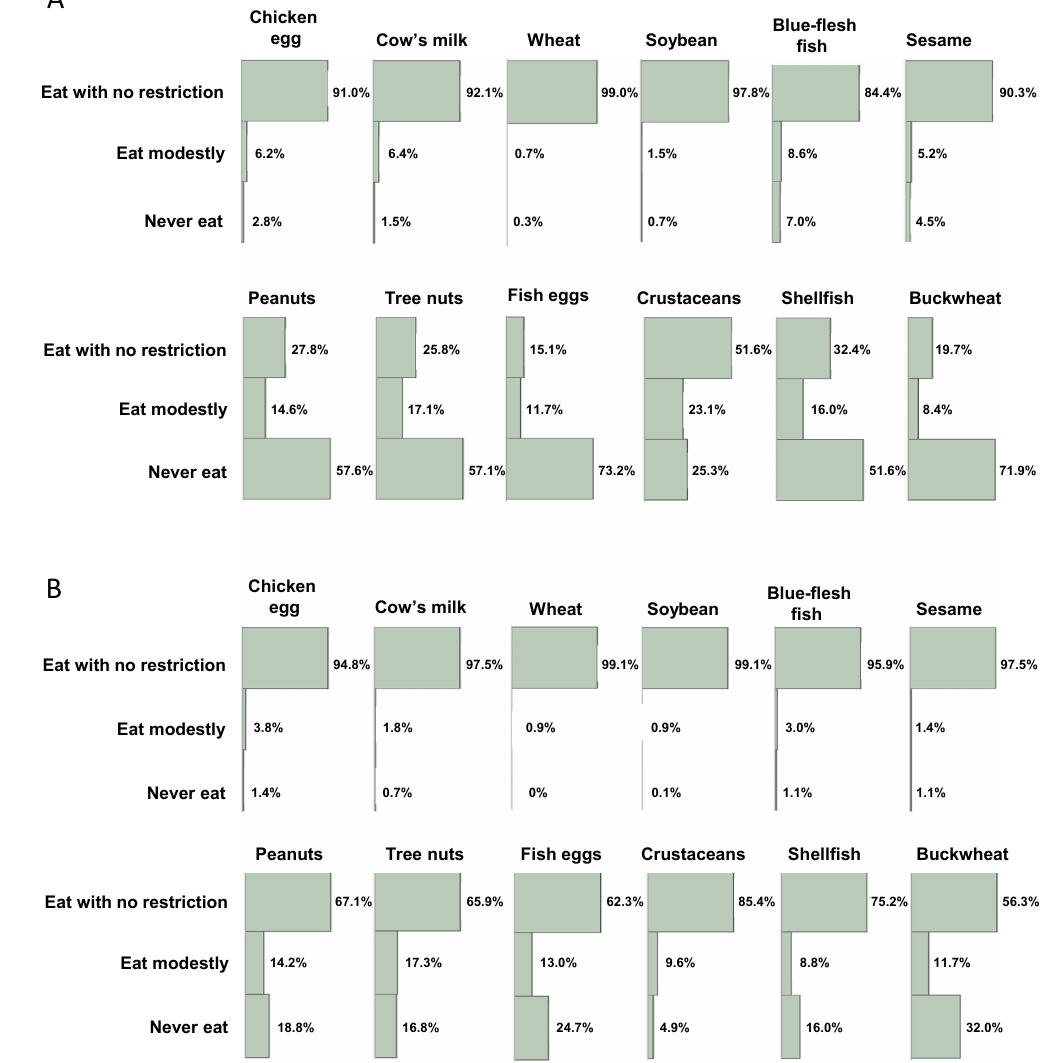
Fig. 1 Rates of restriction on allergenic food intake at 1.5 (A) and 3 years (B) of